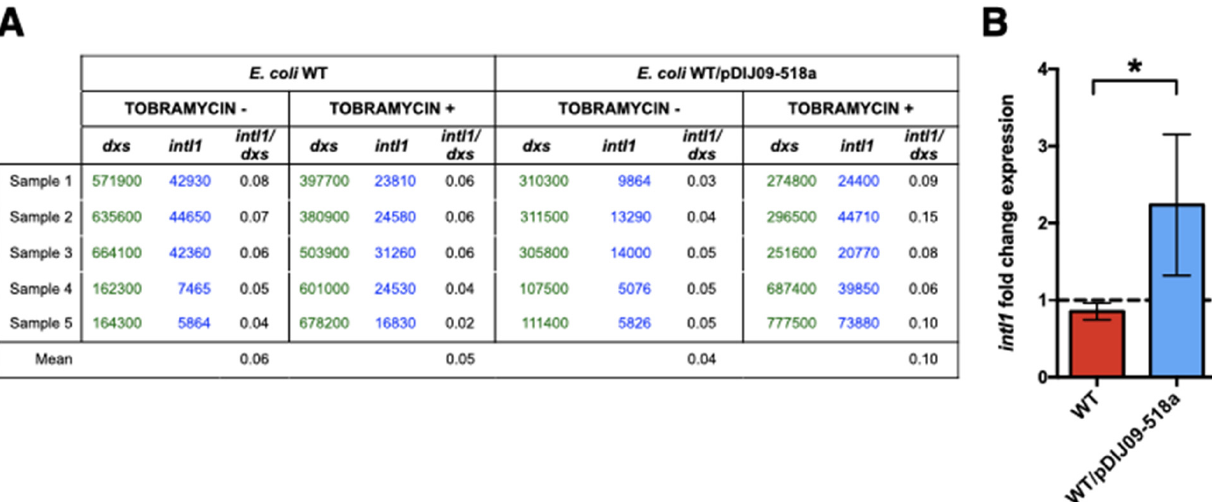
Figure 1. Integrase of class 1 integrons is overexpressed in E. coli harboring the small qnrD -plasmid upon exposure to tobramycin. ( A ) Copy numbers of intl1 determined using absolute quantification of intl1 and dxs , in E. coli MG1656 (WT) and its derivative carrying pDIJ09-518a (WT/pDIJ09-518a); ( B ) fold-change expression of intl1 in WT and WT/pDIJ09-518a exposed to tobramycin in comparison to LB. Data represent median values of 6 independent biological replicates, and error bars indicate mean with SD. * p < 0.05 Mann–Whitney test.